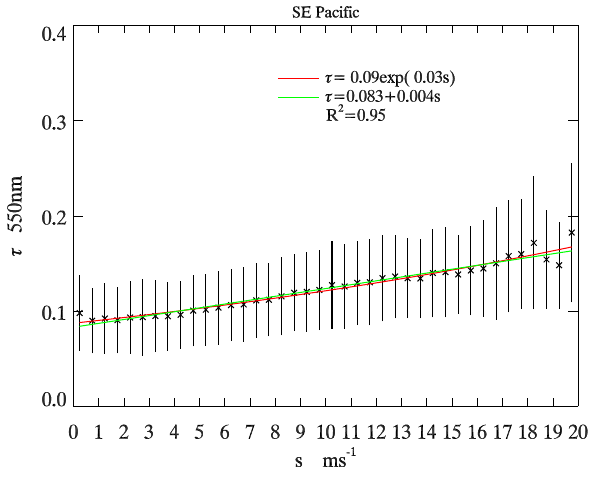
Fig. 6. Relationship between wind speed s and AOD τ over the